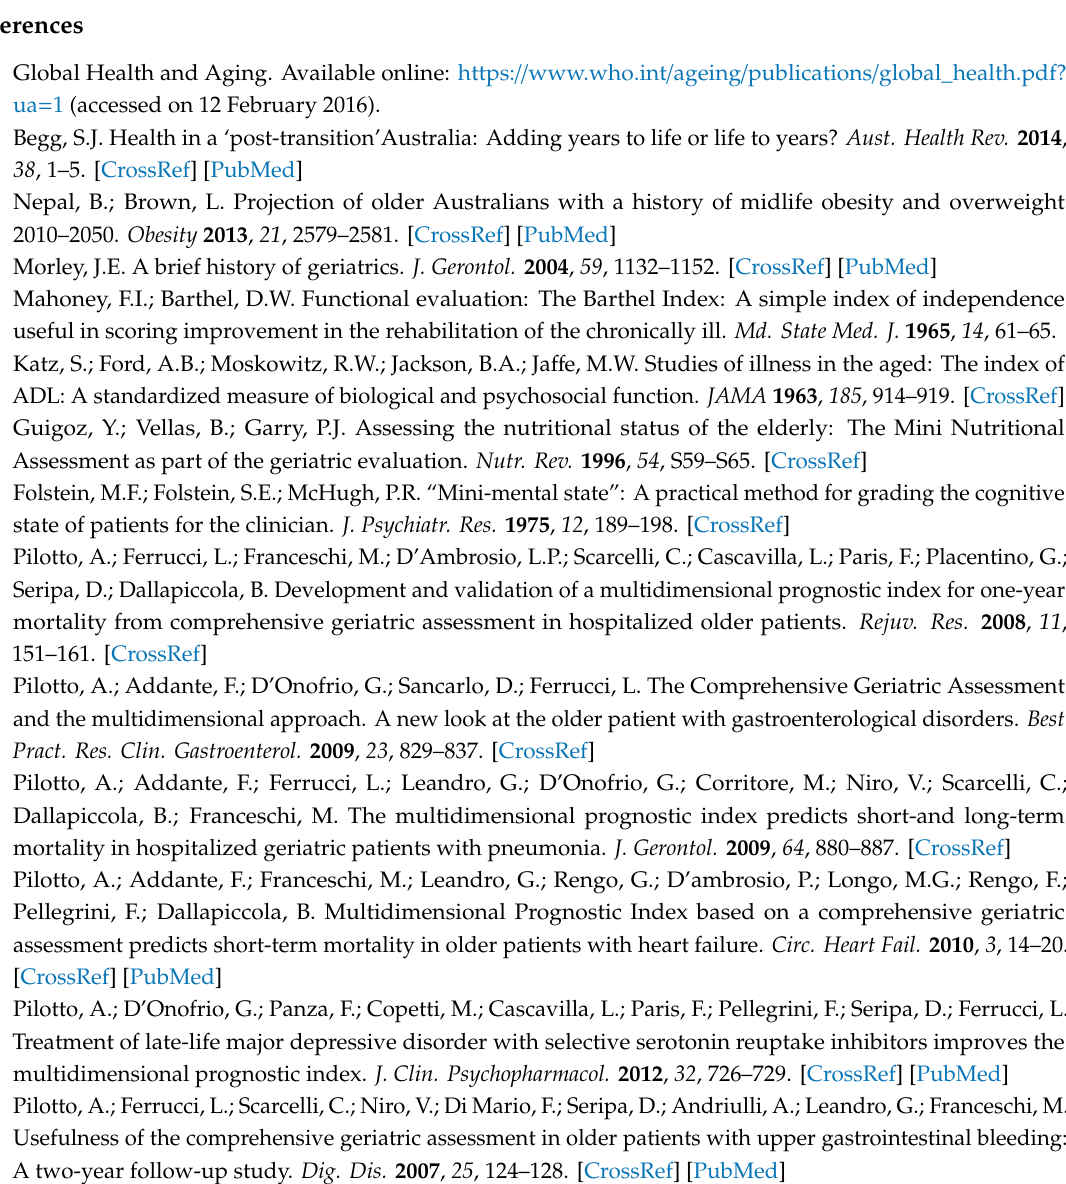
Figure S1. Survival curve for MPI risk categories; Figure S2. Unadjusted and Adjusted ROC curves for original MPI and 12-month all-cause mortality; Table S1. Baseline characteristics according cohort; Table S2. Unadjusted and adjusted logistic regression for original MPI, adapted MPI, and 12-month all-cause mortality; Table S3. FMC cohort hazard ratios for original MPI risk categories; Table S4. Area under the ROC curves for original and adapted